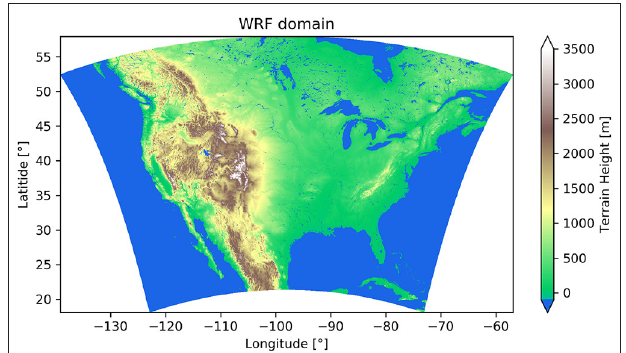
FIGURE 1 | Domain of the Weather Research and Forecasting (WRF)